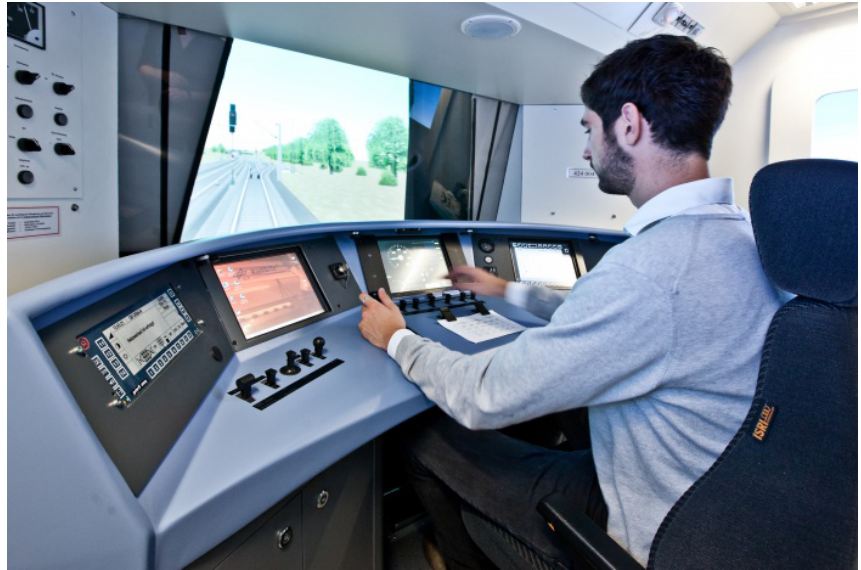
Figure 2: RailSET (Railway Simulation Environment for Train Drivers and